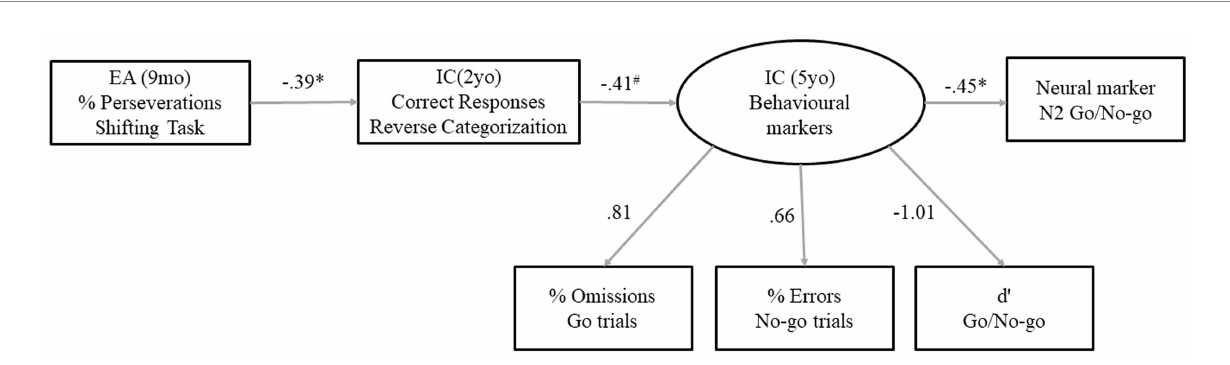
infant’s looking behavior, the Reverse Categorization task relies on children’s motor behavior. In the same line, IC in the delay tasks at 2 and 3 years of age is also intercorrelated; they are foreseeably intended to measure the same aspect of IC (i.e., self-control), which would explain the shared variance over time (Kochanska et al., 2000; Mulder